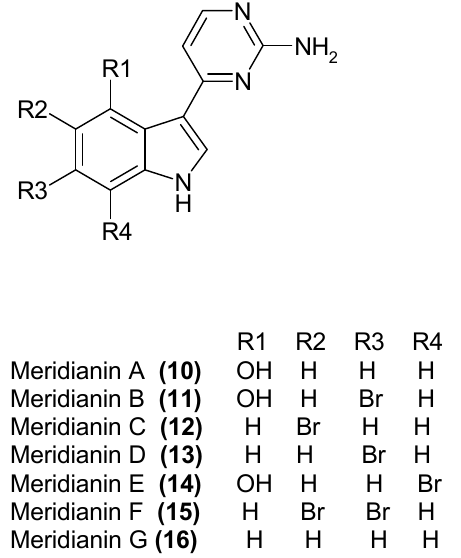
Figure 4. Meridianin structures isolated from Aplidium meridianum